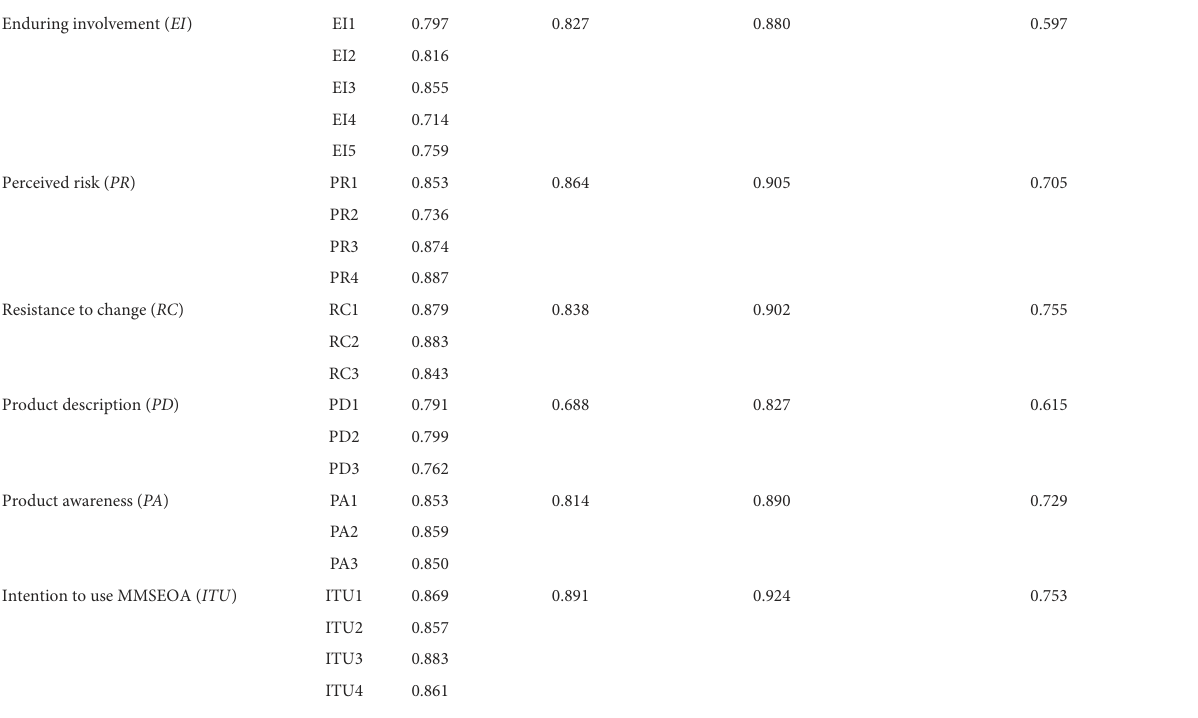
TABLE 4 Model assessment.